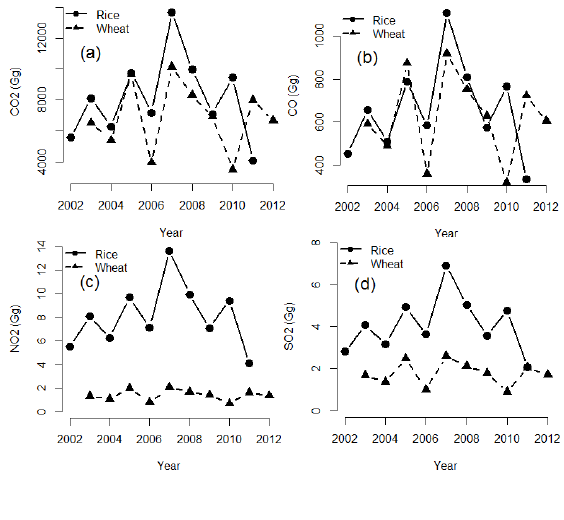
Table 7. Total emissions (Gg) of CO 2 , CO, NO 2 , SO 2 and TPM during wheat harvesting season in